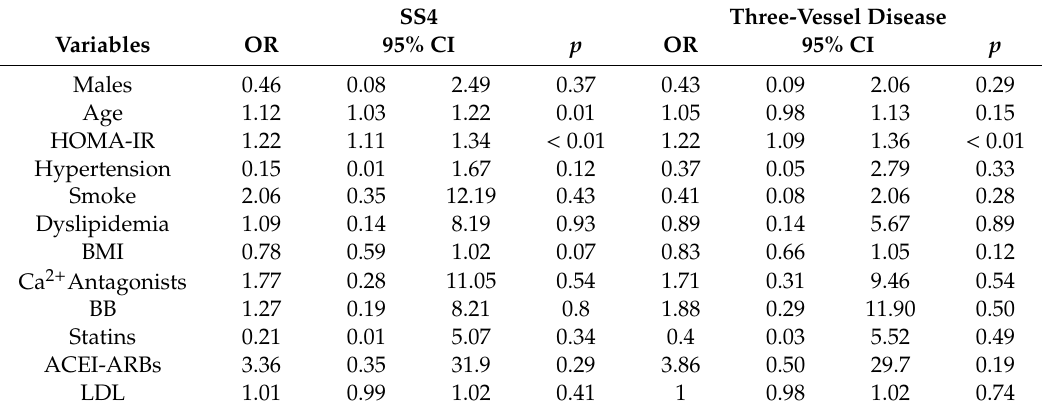
Table 2. Adjusted binary logistic regression analysis for highest quartile of SS (SS4) and for three-vessel disease. SS4 Three-Vessel Disease